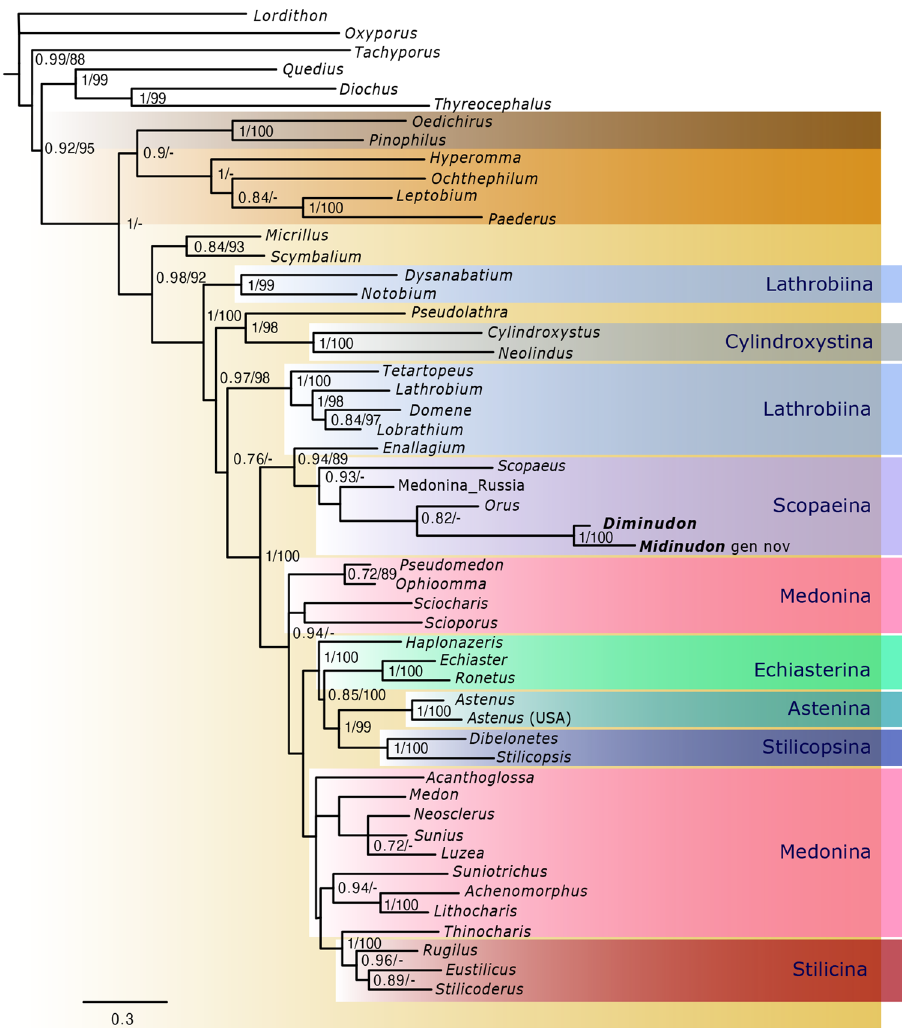
Figure 1. A 50% majority-rule consensus tree from a Bayesian Inference analysis of combined molecular and morphological datasets. Posterior probabilities (PP) and ultrafast bootstrap supports (UFB) values are shown at the corresponding nodes in PP/UFB format. Tribes and subtribes of Paederinae highlighted in colour. Extinct genera names written in